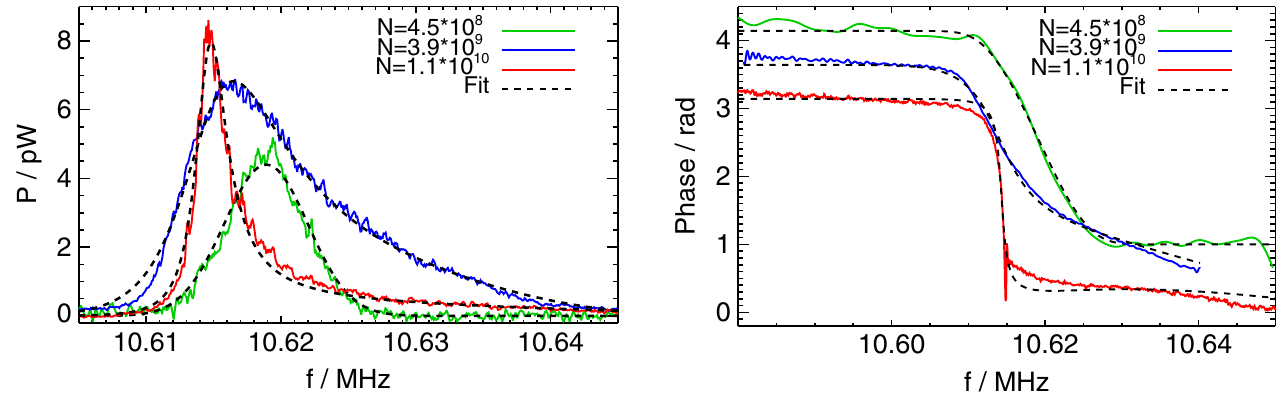
FIG. 2. (Color) Lower Schottky sideband at m ¼ 50 measured with different ion numbers and the corresponding fits. The corresponding (cid:1) U sc are 0., 0.9, and 1.8, respectively. The curves are rescaled for a better prospect.